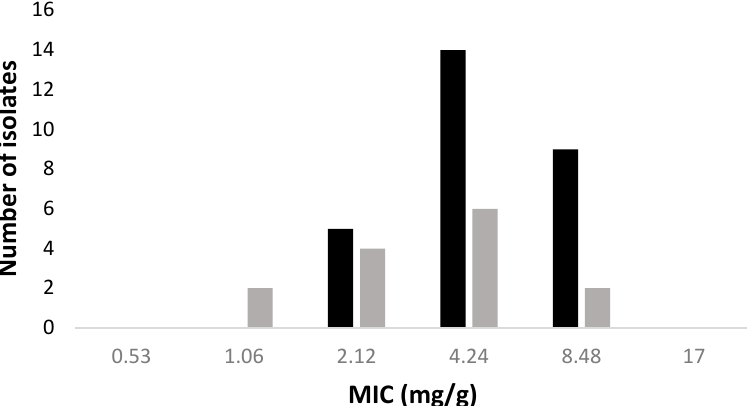
Figure 1. Minimum inhibitory concentrations (MIC) of ozonated oils against 28 methicillin-resistant S. aureus (MRSA) (black) and 10 methicillin-susceptible S. aureus (MSSA) (grey) strains.